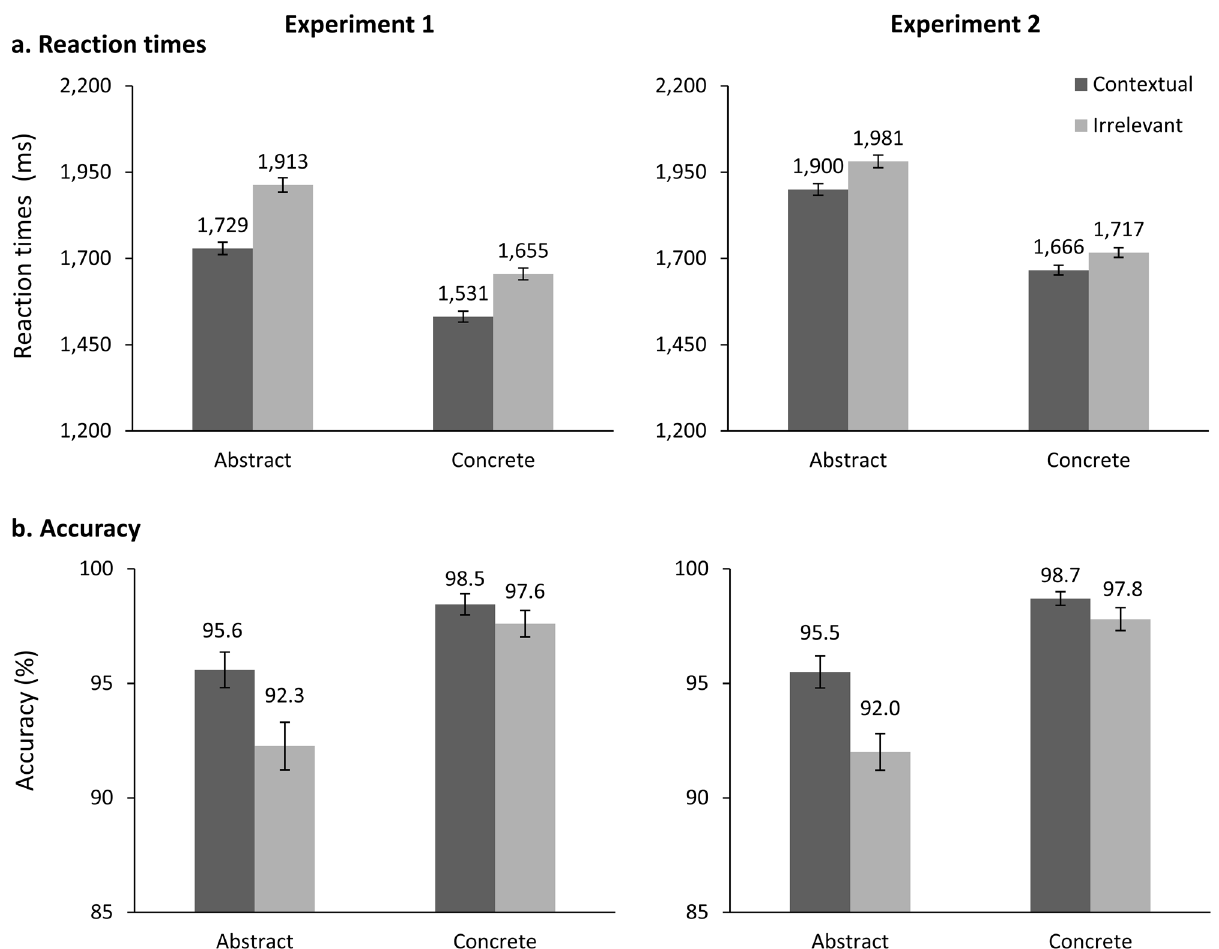
Figure 2. Descriptive statistics on mean reaction times (ms; ( a )) and accuracy (%; ( b )) in the synonym judgment task after contextual and irrelevant cues in Experiment 1 and Experiment 2. Error bars represent ± 1 standard